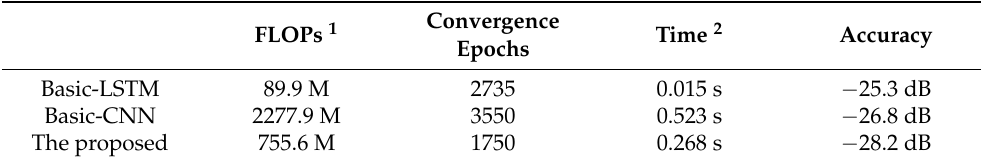
Table 1. Comparison of application complexity.